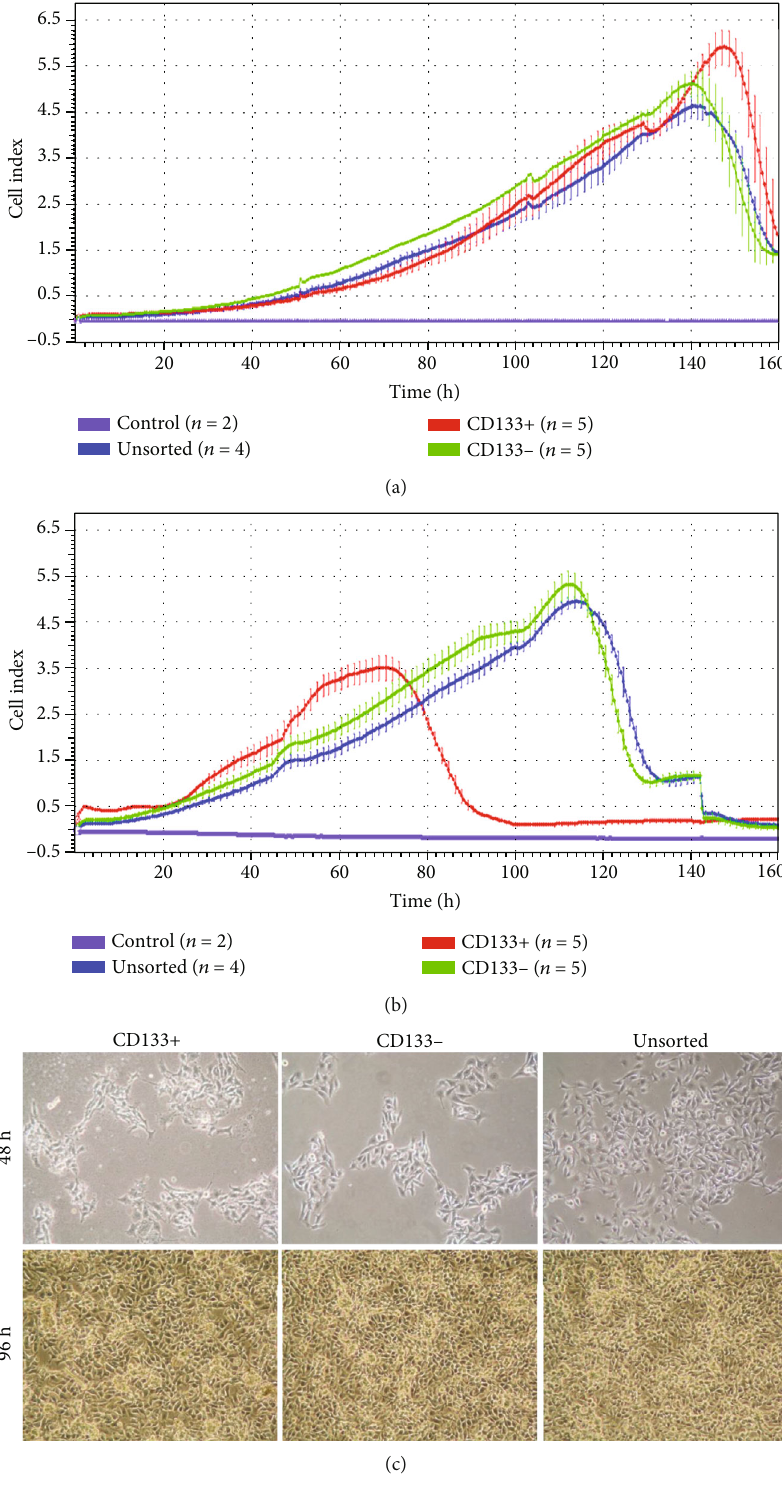
Figure 2: Melanoma cell characteristic after immunomagnetic cell sorting: (a, b) growth comparison of three cell populations using real- time cell analysis seeded with di ff erent cell densities: 1 × 10 3 cells/cm 2 (a) and 4 × 10 3 cells/cm 2 (b); (c) cell morphology of CD133 positive (CD133+), negative (CD133-), and unsorted (CD133+/-) B16-F10 cells after 48 h and 96h of